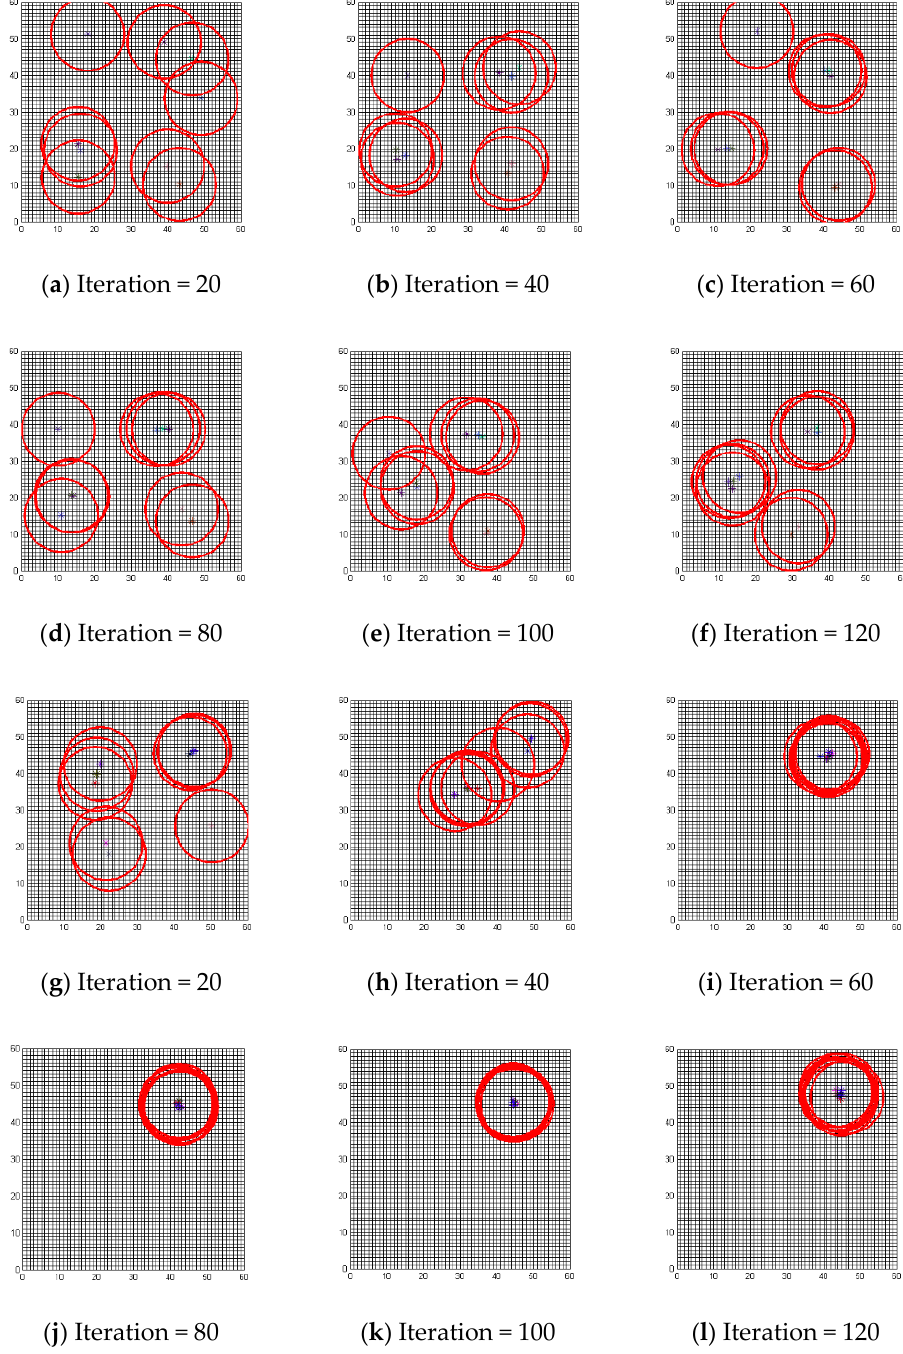
Figure 14. Simulation results for aggregation in noise free environment: ( a – f ) The controller in Reference [27]; ( g – l ) BCCS.